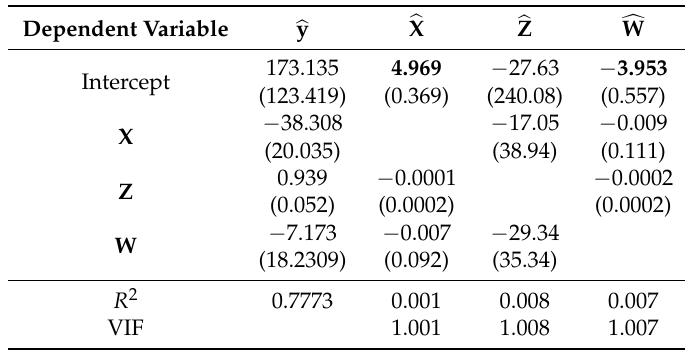
Table 5. Estimation by ordinary least squares (OLS) of the first simulated model and its corresponding auxiliary regressions (estimated standard deviation in parenthesis and coefficients significantly different from zero in